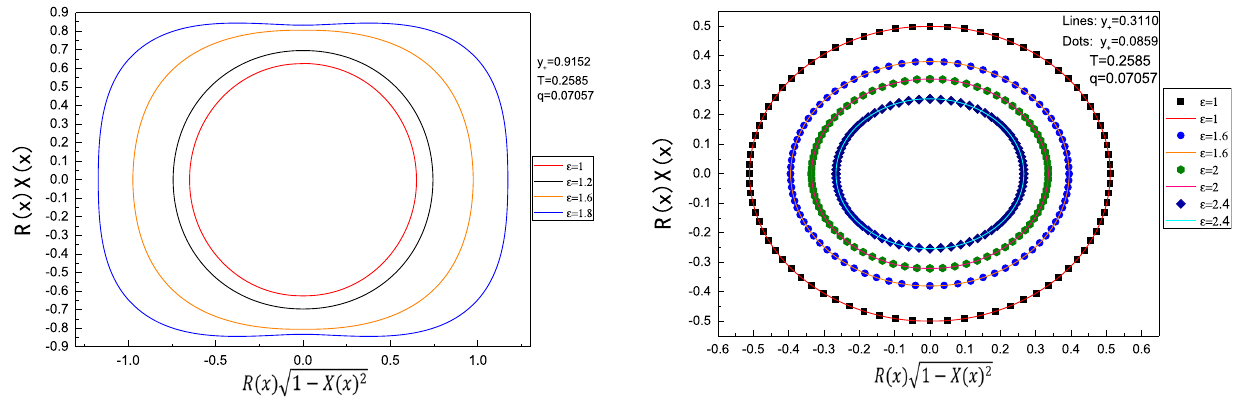
Fig. 4 Hyperbolic embedding of the cross section of three black hole horizons for different values of ε at T = 0 . 2585 and q = 0 . 07057. Left: the horizon geometry of large branch for y + = 0 . 9152. Right: the horizon geometry of two small branches for y + = 0 . 3110 (lines) and y + = 0 . 0859 (dots) Fig. 5 Hyperbolic embedding of the cross section of the large black hole horizon for different values of charge q with y + = 1 . 5 and ε = 1 .